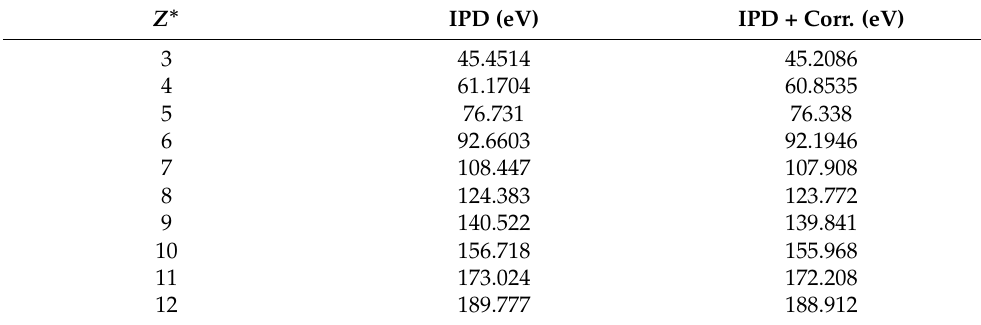
Table 1. Correction to the IPD due to Equation (18) for an Al plasma at T = 70 eV and ρ = 2.7 g/cm 3 (conditions of Ciricosta’s experiment